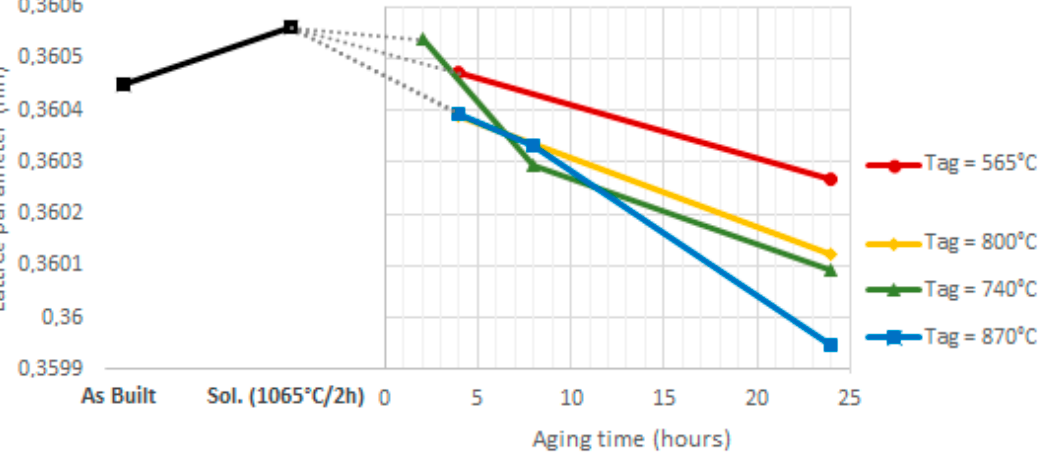
Figure 21. Lattice parameter of the γ matrix calculated from the X-Ray diffraction (XRD) spectra of Figure 20 with the Bragg equation. Trends at different heat treatment conditions (as-built, solutioning and aging at different temperatures and times).